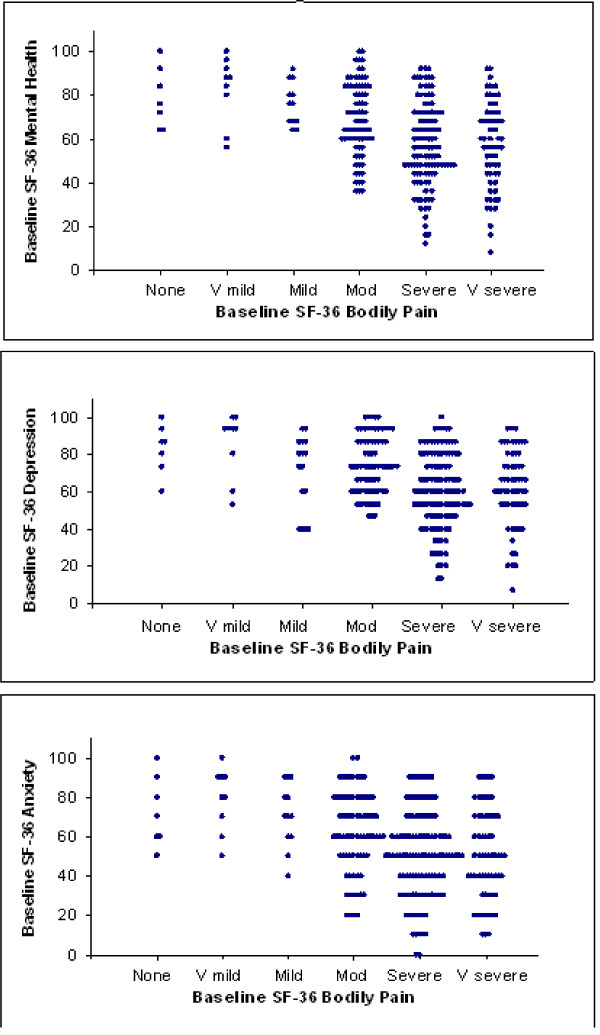
Baseline mood vs. pain in 277 patients with subacute sciatica, regardless of subsequent surgical or nonsurgical treatment. Overall intensity of "bodily pain" over the month before seeing a surgeon for sciatica explains about 13% of the variance in depressive and anxious feelings over the same period (p < 0.0001), assessed by the five-item SF-36 Mental Health Subscale (top panel). Higher scores on the y axis correspond to better mood. The other panels show similar relations to pain of the three items of the subscale pertaining to depressed mood (middle) and the two items pertaining to anxiety (bottom).